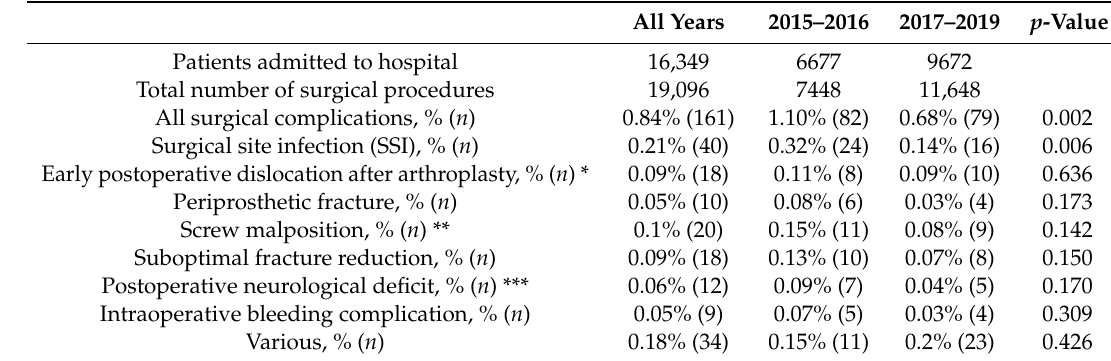
Table 1. Surgical complications stratified by study years.